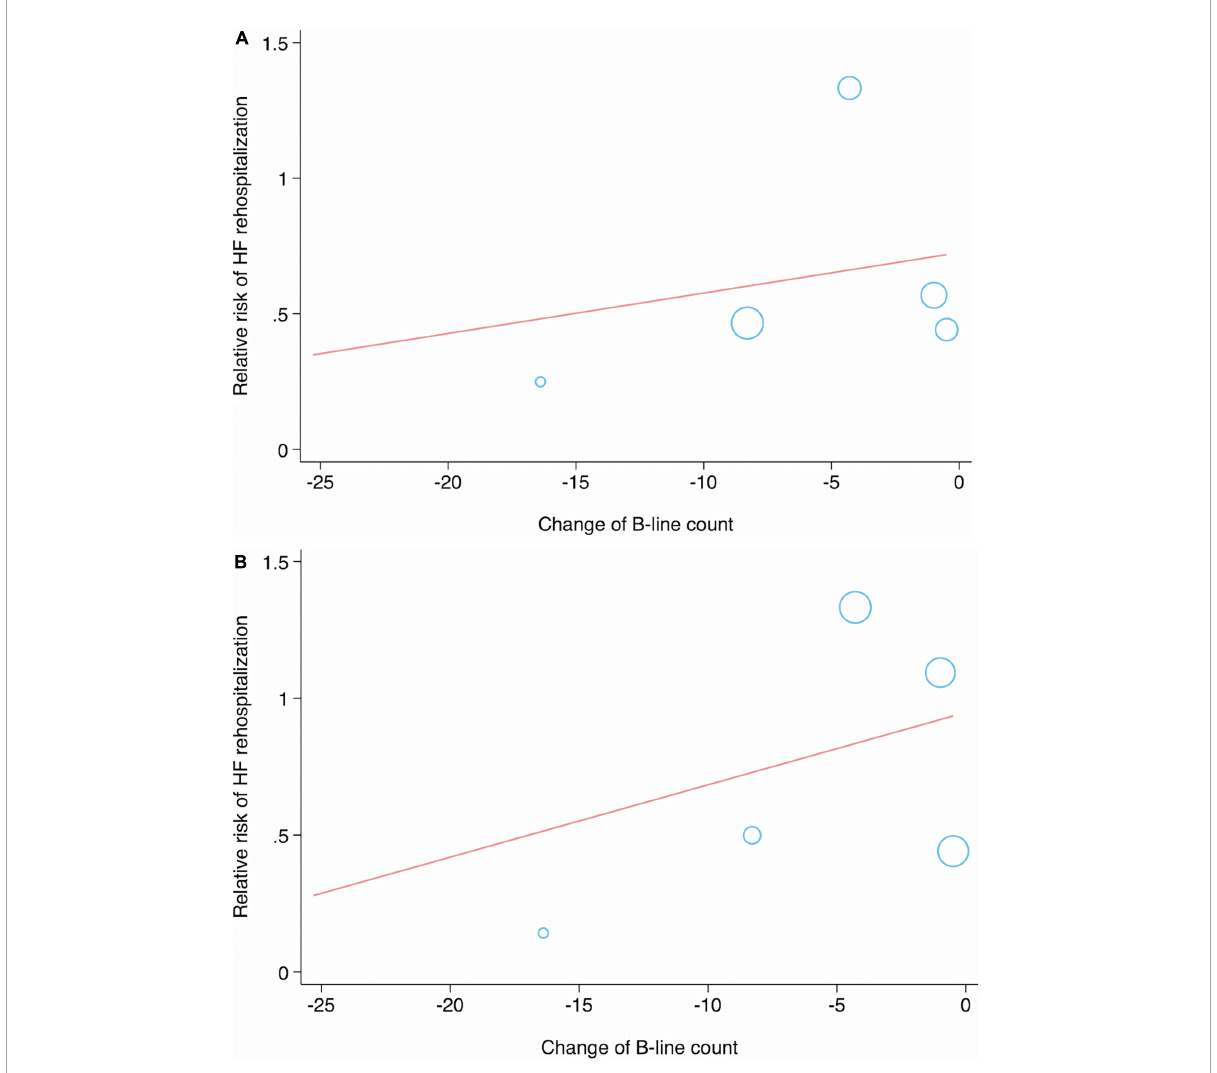
FIGURE6 Meta-regression analysis showing significant associations between change in B-line count and major adverse cardiac event (A) , or HF rehospitalization (B) .